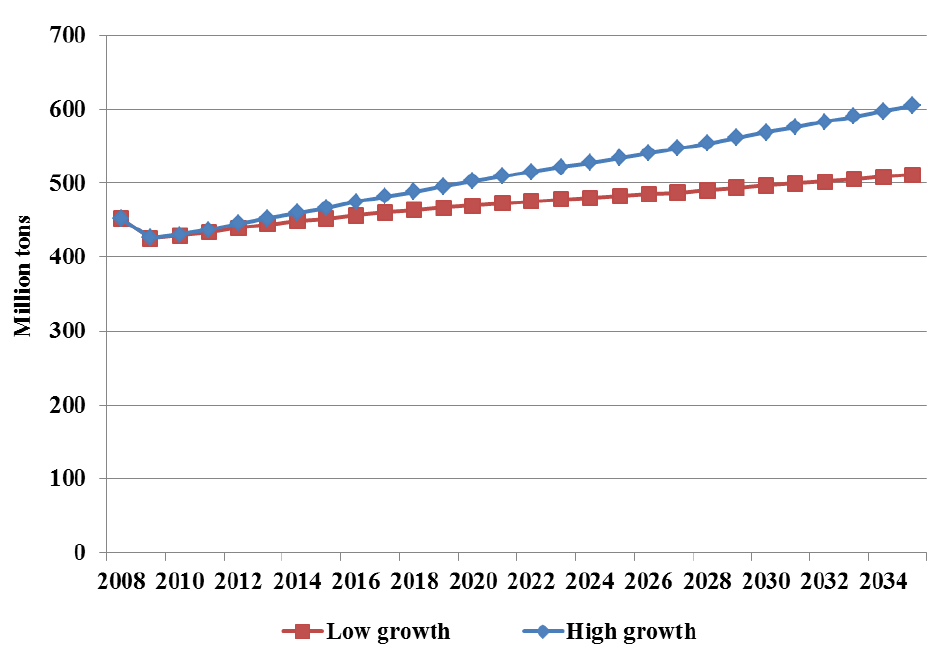
Figure 11. Projected carbon dioxide